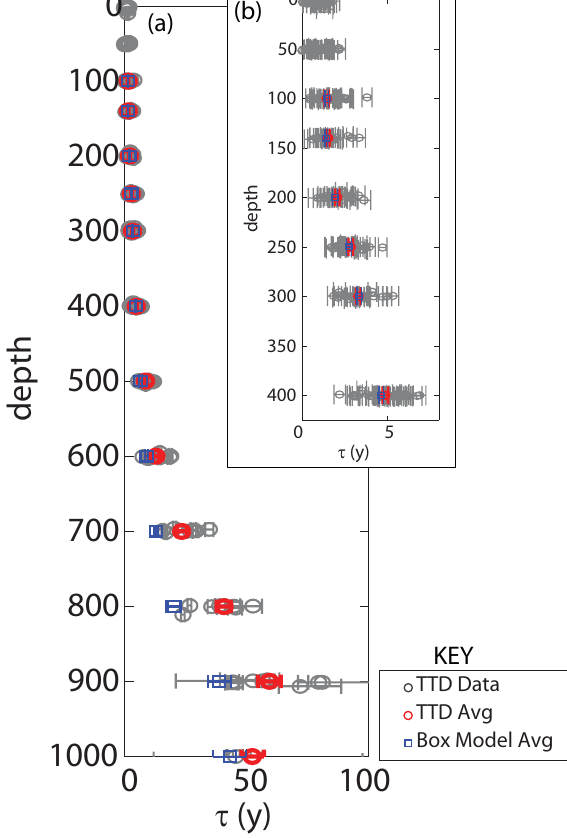
Fig. 3. Water ages ( τ) calculated from a distribution of transit times using 3 He data (as described in text) for every sample (gray circles) and as depth averages (red circles) (a) for depths 0 to 1000m and (b) only for depths 0 to 400m. For comparison, depth averages of water ages calculated from a box model approach are also shown (blue squares). Error bars on individual data points reflect 1 σ un- certainties. Error bars on depth averages reflect standard error of mean of measurements at that